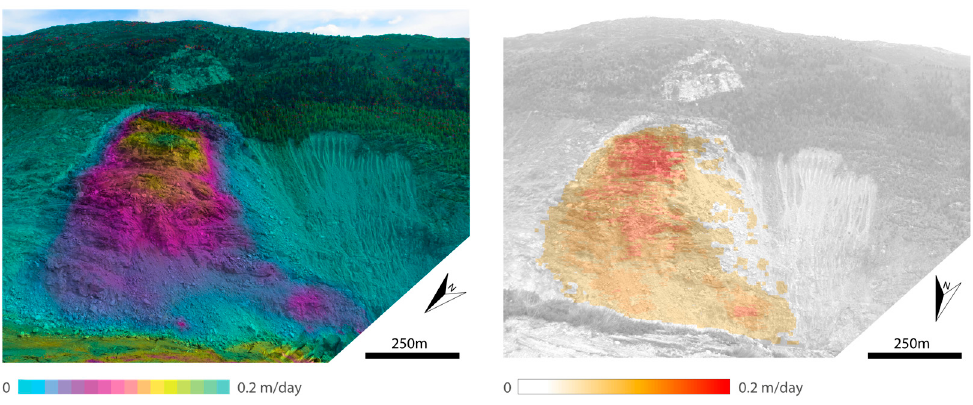
Figure 6. Surface velocity at Moosfluh measured with ground based remote sensing methods. (Left) GPRI measurements (stack of 1 min interferograms over 8 h) performed on 28 September 2017. (Right) Average velocity obtained applying DIC on time lapse camera data (image pair 26–28 September 2018) acquired from Driest (see camera location in Figure 1). Unreliable and/or outlier DIC values are masked out. The large deformation occurring in the lower portions of the Moosfluh slope is well mapped from both techniques in a short temporal frame, and average velocities are in agreement with independent ground measurements (cf. Figure 5, p75).